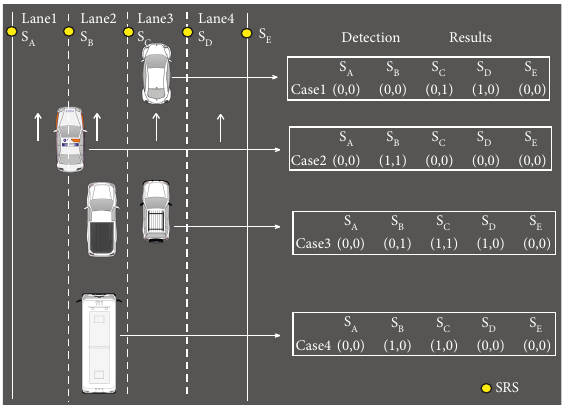
Figure 9: Diagram of cooperative SRS detection result calibration.